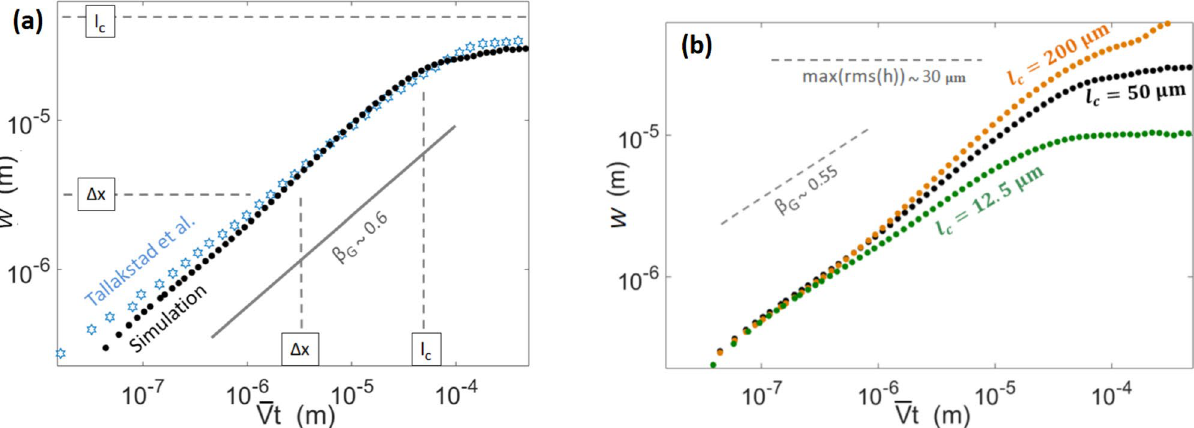
Figure 4. ( a ) Standard deviation of the width evolution of the crack front as a function of the mean crack advancement, as defined by Eqs. (3) to (5) for the chosen simulation (plain points) and for the experiments 28 (hollow stars) (out of Fig. 8, Expt. 5 of the experimental paper). The continuous line has a slope 0.6, close to that of the experimental points: β G ∼ 0.55 . The numerical β G , obtained with a linear root mean square fit of the growth of W , is estimated as β G = 0.60 ± 0.05 . The dashed lines mark the observation scale (cid:31) x , corresponding to the experimental camera pixel size, and the chosen correlation length for the simulation l c = 50 µ m. ( b ) The same width function for simulations with different correlation lengths l c . The rest of the parameters are as defined in Table 1. The slope and plateau of the experimental data (shown in ( a )) is marked by the dashed line for comparison.